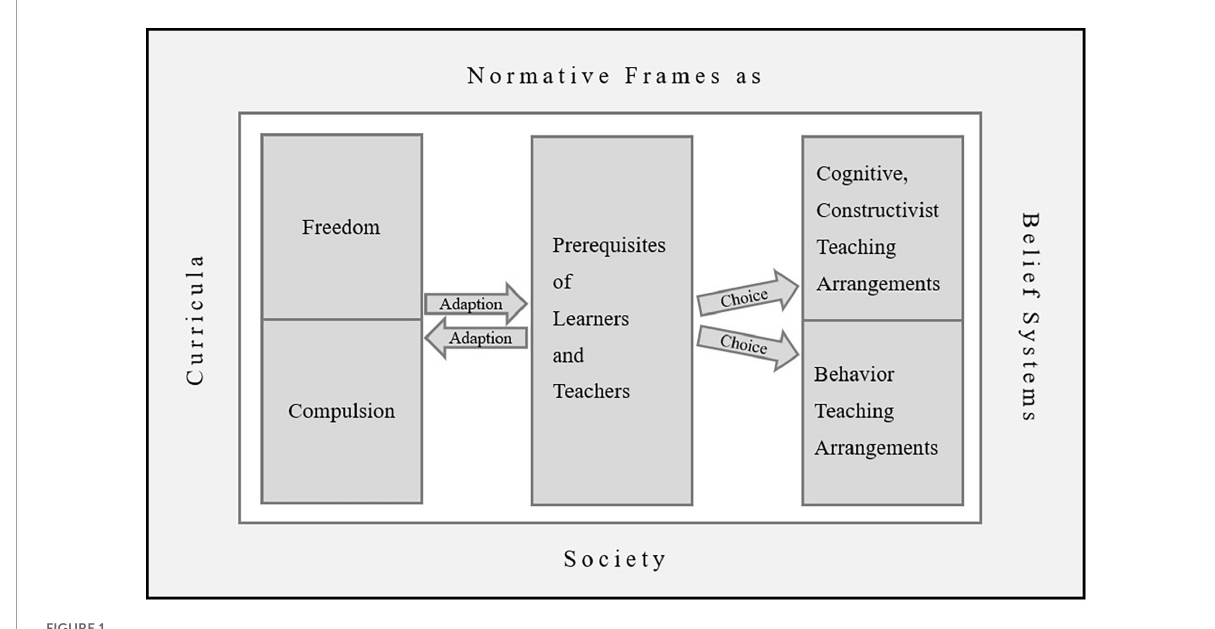
FIGURE1 Dimensions of